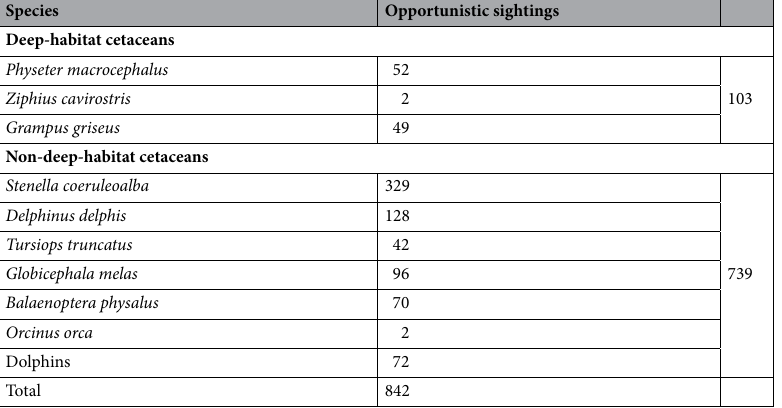
Table 2. Number of cetaceans recorded from 1993 to 2014 by the Spanish Institute of Oceanography. Variables in the logits are ordered according to the order of entrance in the stepwise modelling procedure. Spr SPRING, Sum summer, Aut autumn, Win winter, Lon geographic longitude, TD distance to towns, stdevSST standard deviation of sea surface temperature, madSST median absolute deviation of temperature, msalt salinity, ChlA Chlorophyll A concentration, H&L Hosmer & Lemeshow test, AIC Akaike Information Criterion, AUC area under the receiver operating characteristic (ROC) curve. The variables are ordered by